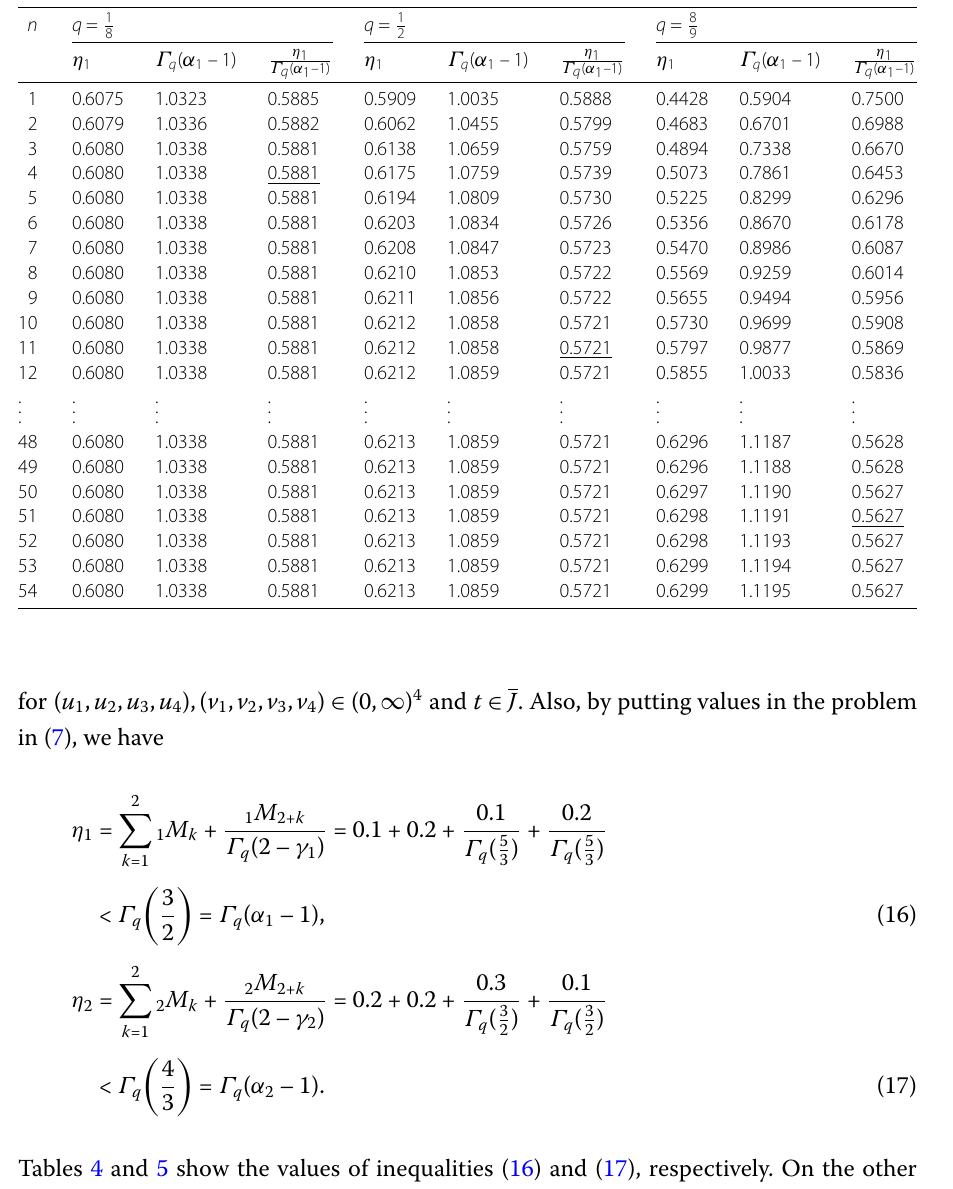
Table 4 Some numerical results of η 1 and Γ q ( α 1 – 1) from inequality (16) in Example 1 for } . One can check , 1 , 8 q ∈ { 1 8 2 9